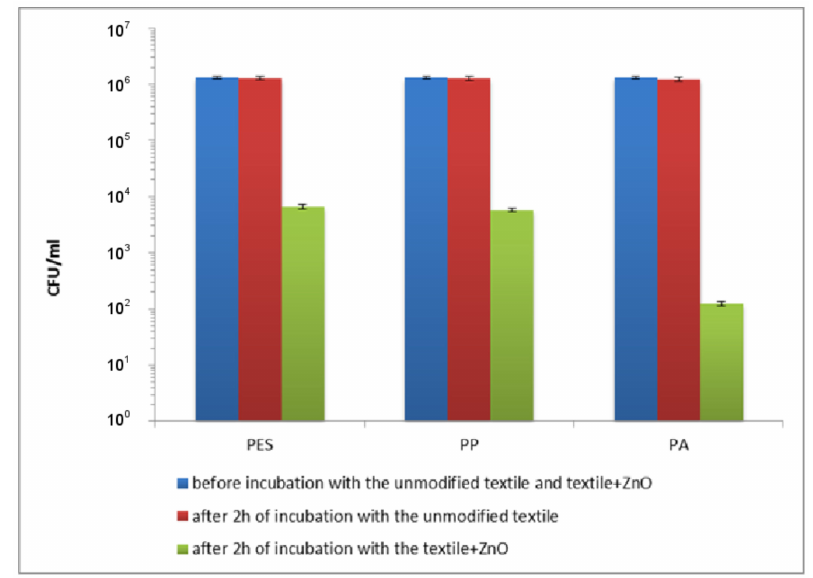
Figure 11. The effect of the modified polymer textiles on the viability of E. coli determined by the serial dilution method.